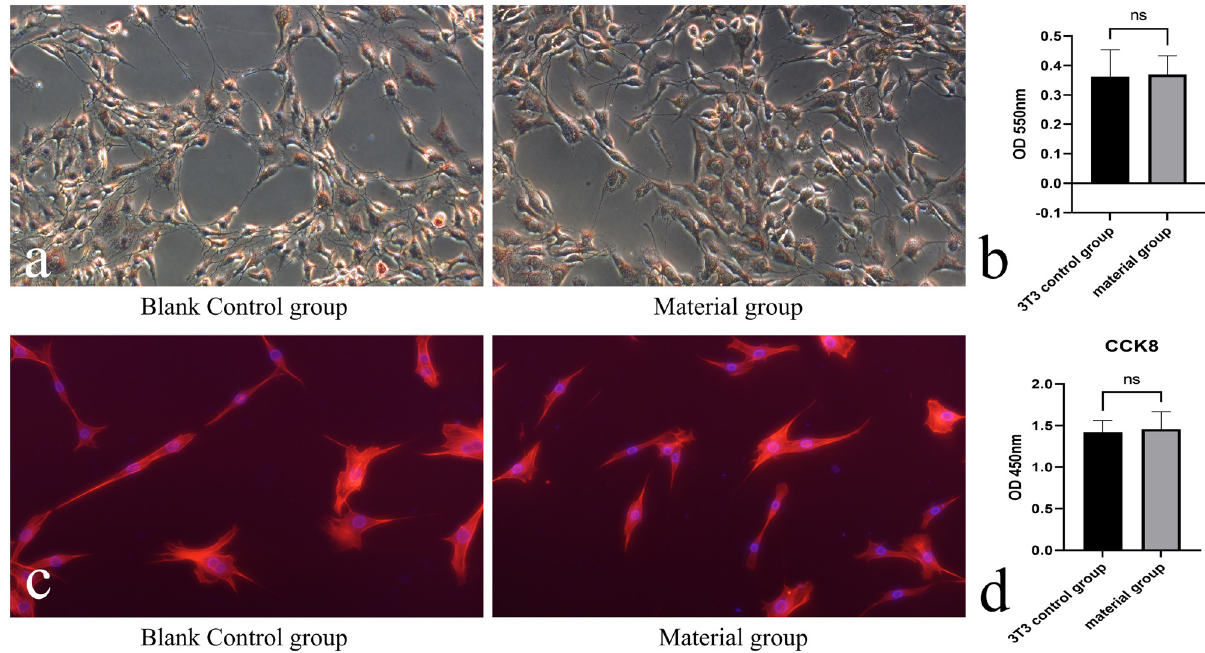
Figure 8: ( a ) Comparison under the microscope in the NRU test; ( b ) e ff ect of material group and blank control group on NRU in BALB/c 3T3 cells ( p > 0.05 ) ; ( c ) comparison of cytoskeleton staining between material group and blank control group; and ( d ) e ff ect of material group and blank control group on NIH 3T3 cell proliferation ( p > 0.05 )